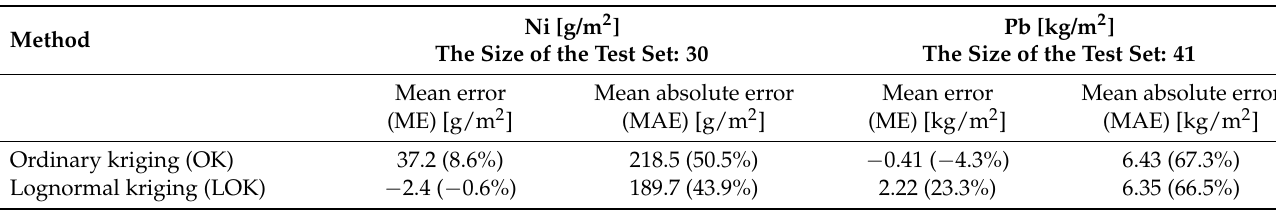
Table 5. The results of the assessment of the accuracy of the Ni and Pb abundance estimates in the test sets based on 2 geostatistical methods (the errors related to the average abundance in the test set, expressed as a percentage, are shown in brackets).